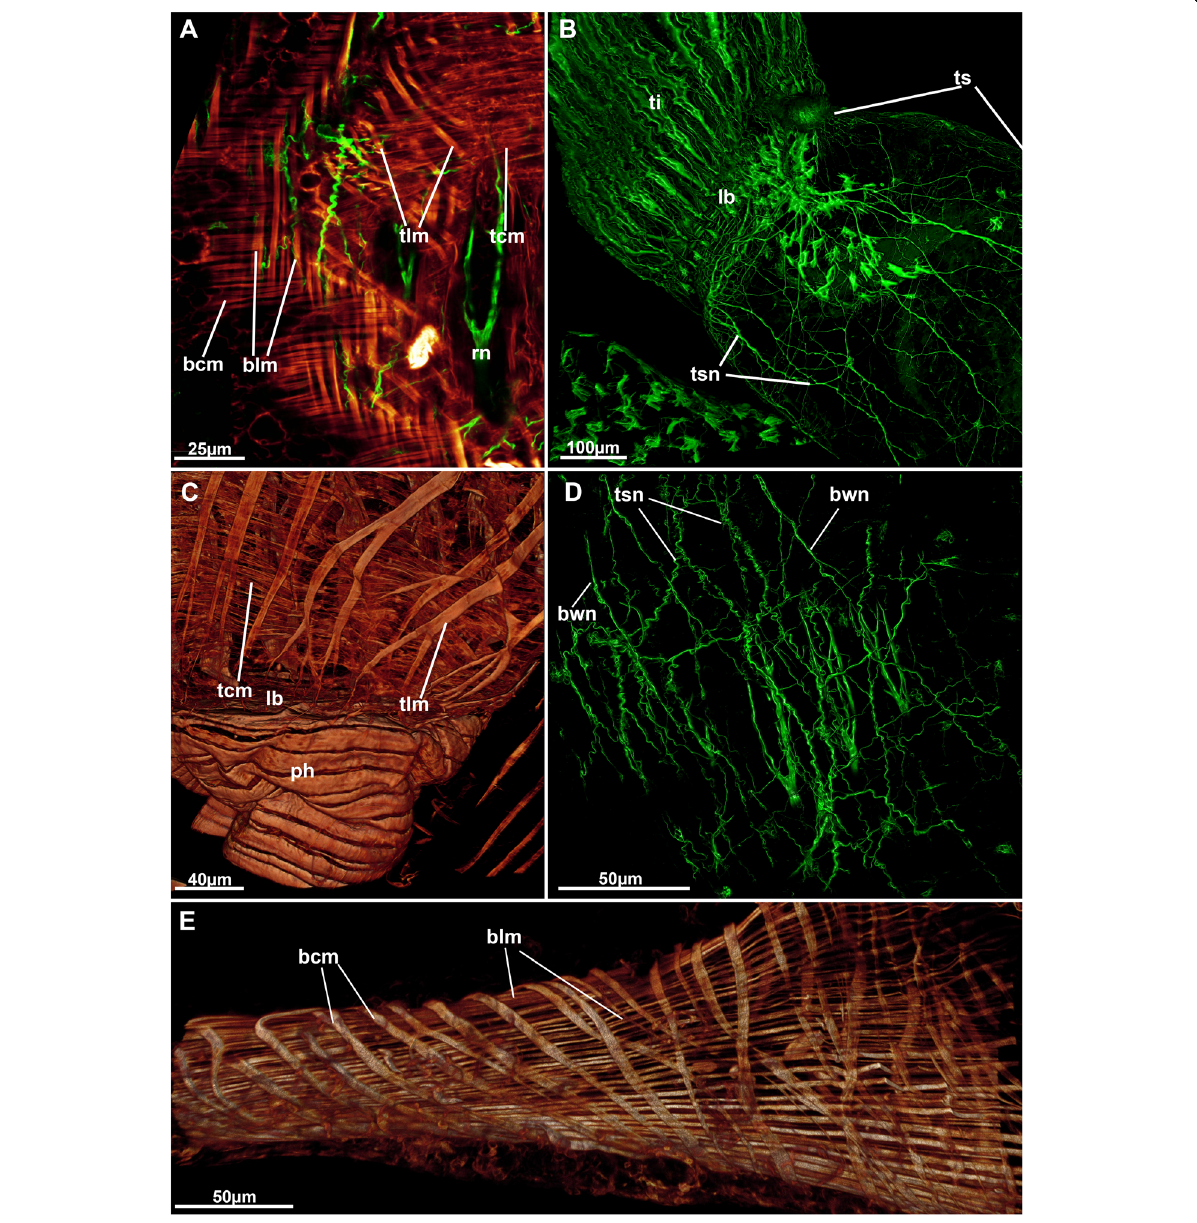
Fig. 14 Neuro-muscular system of the peripheral areas of Stephanella hina . Confocal laser scanning microscopy stacks based on acetylated alpha- tubulin labelling. Volume renderings, projections or optical slices. Acetylated alpha-tubulin in green LUT, f-actin in glow LUT. a Optical section showing body wall musculature on the left and tentacle sheath musculature on the right. Both show thick longitudinal fibres and thinner circular fibres. b Overview of an extended polypide showing diffuse tentacle sheath innervation in form of a plexus. c Tentacle sheath musculature of a retracted polypide showing both circular and longitudinal fibres close to the lophophoral base. d Diffuse nerve plexus of the body wall and partially underlying tentacle sheath nervous plexus. e Orthogonal grid of the body wall musculature in the thin, ‘ stolon ’ -like parts of the